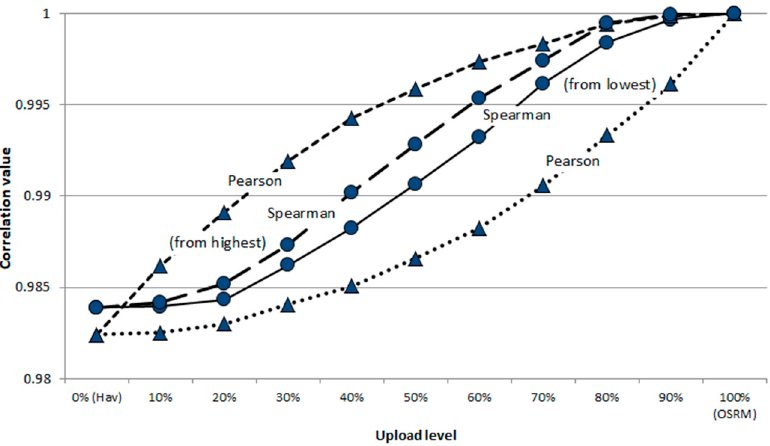
Figure 6. Pearson’s and Spearman’s correlation coefficient between DistOSRM matrix values and successively updated mixed-matrix.